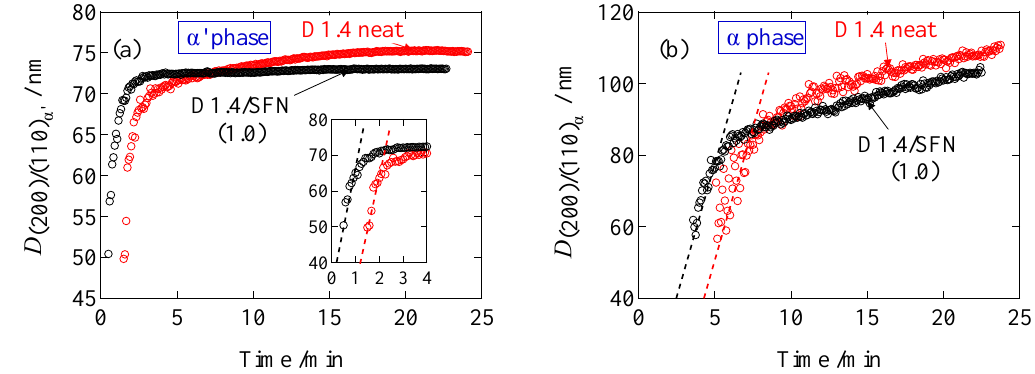
Figure 6. Comparison of the crystallite size evaluated by the Scherrer’s equation for ( a ) α’ phase and ( b ) α phase. Inset in ( a ) shows the expanded view.